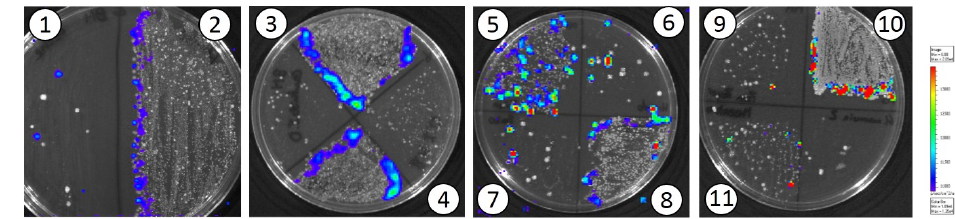
Figure 2. In vitro and in vivo detection of L. lactis MG1614 transformed with pMG36:: luxABCDE . ( A ) GM17 agar plate with transformed (left) and non ‐ transformed (right) L. lactis MG1614 cells. ( B ) Mouse immediately (left) and 20 min (right) after being fed with L. lactis pMG36e:: luxABCDE .